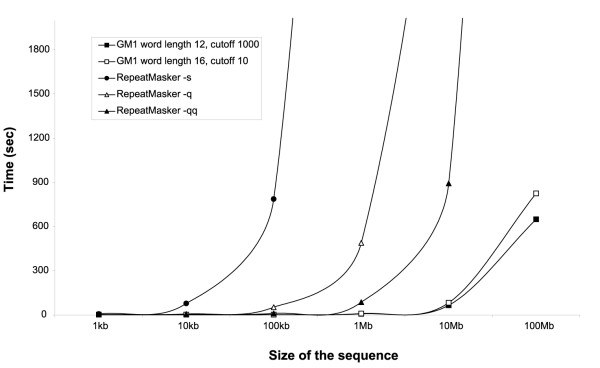
The speed test between two masking methods: RepeatMasker and GenomeMasker. Both programs were tested with several parameters and different template sizes. Masking of the entire human genome takes 6–7 hours with the GenomeMasker. Programs were executed on a 2.66 GHz Intel Xeon™ processor with 6 GB of RAM.